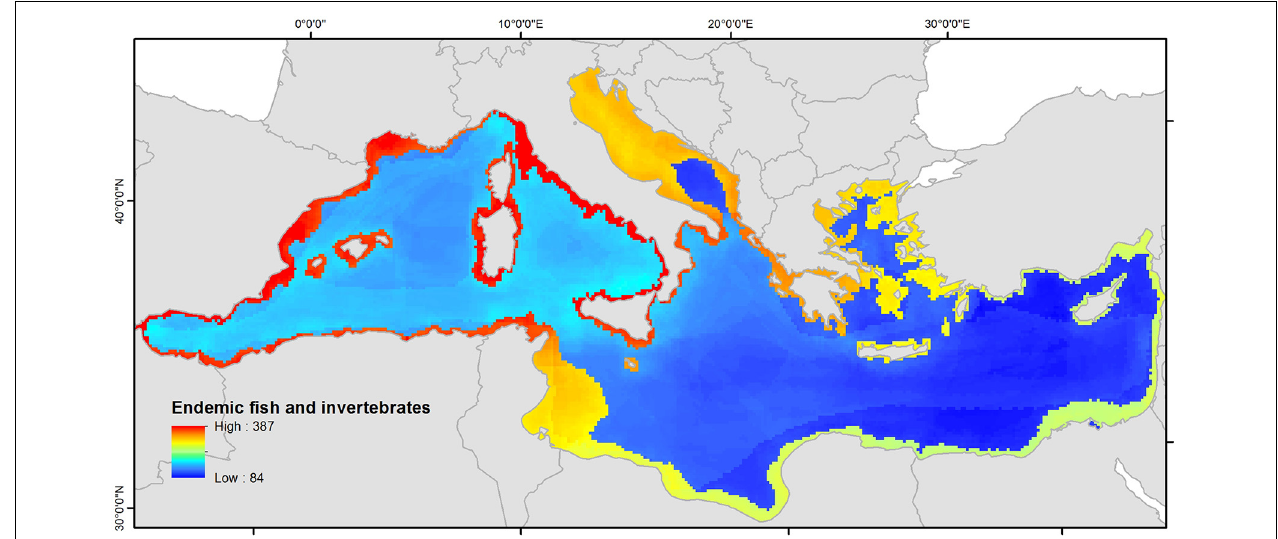
FIGURE 7 | Richness (number of species in a 10 × 10 km grid) of native fish and invertebrates in the Mediterranean Sea. The data are plotted using a linear scale from minimum to maximum values.